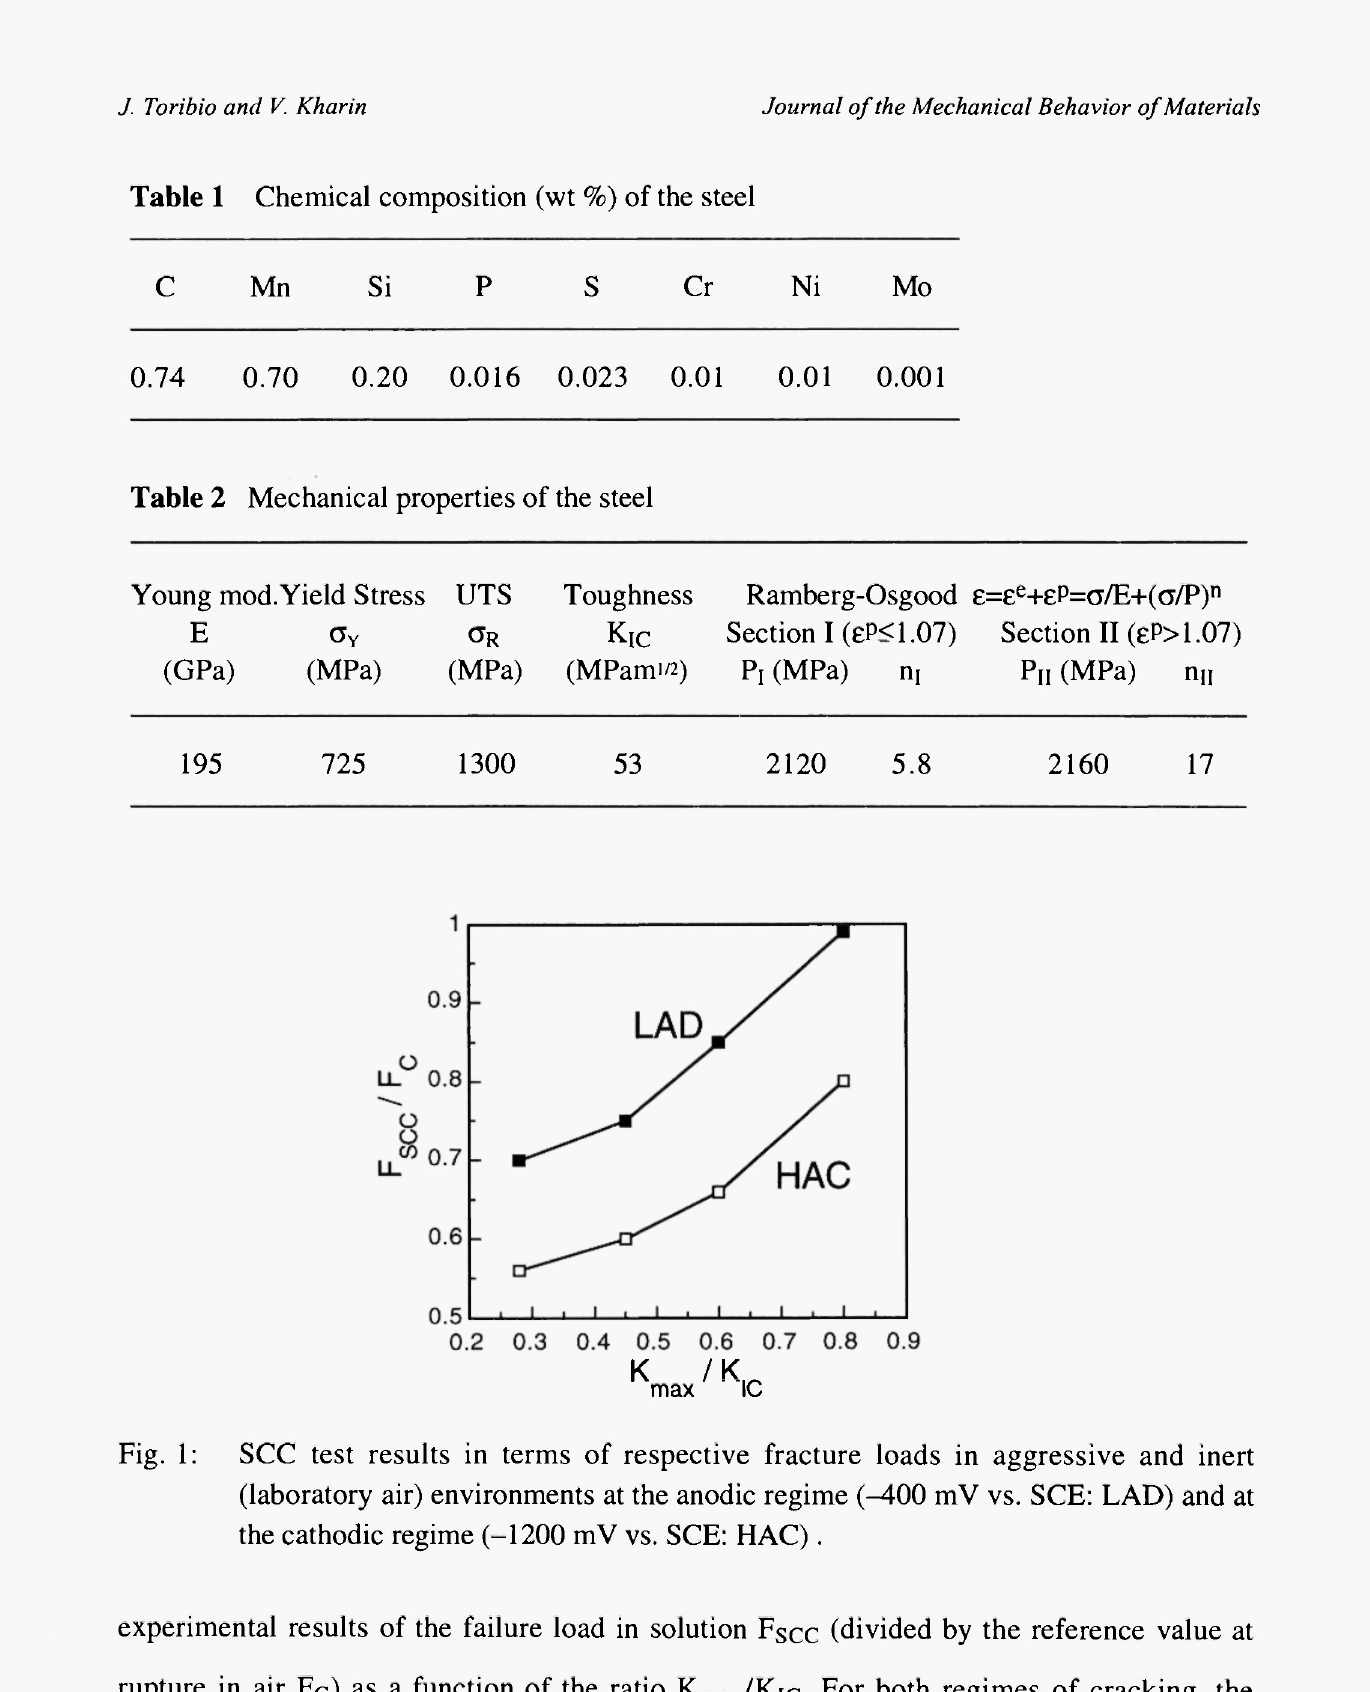
Chemical composition (wt %) of the steel